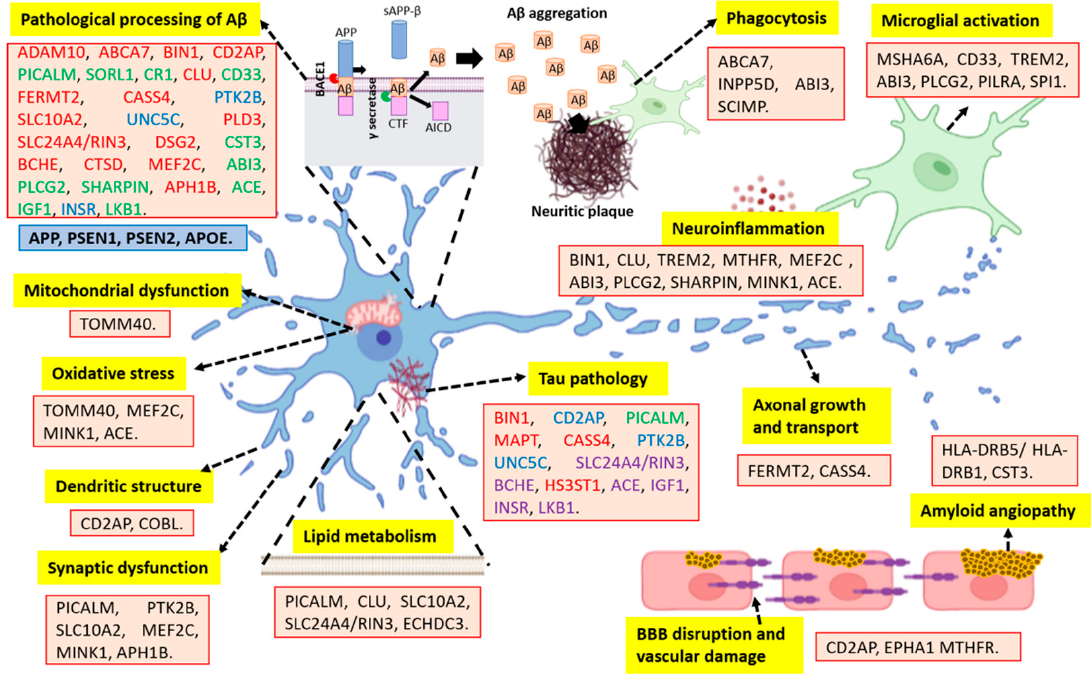
Figure 2. Schematic representation of multiple genes and their association with neuropathological events in AD. The four classical genes associated with familial AD are in the blue box, whereas other novel genes related to sporadic AD are in the red boxes. Word color-coding: red: increased production/aggregation of A β or tau; green: alteration in the clearance of A β or tau; blue: A β - or tau- mediated neuronal damage; purple: Tau phosphorylation. Furthermore, the respective associations with neuropathological mechanisms are indicated in yellow boxes. Abbreviations: AICD: amyloid precursor protein intracellular domain; APP: amyloid precursor protein; BACE1: β secretase; BBB: blood–brain barrier; CTF: C-terminal fragment; sAPP- β : soluble amyloid precursor protein β . This figure was created with